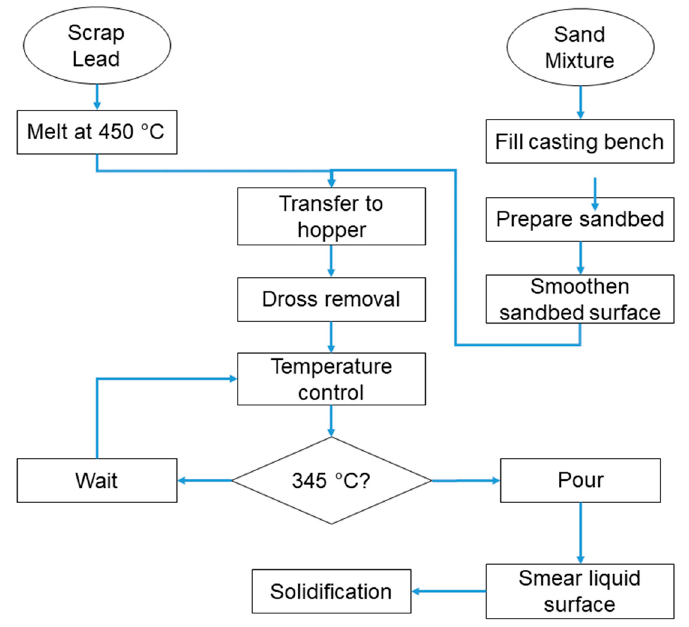
Figure 2. Lead sheet sand casting process workflow.